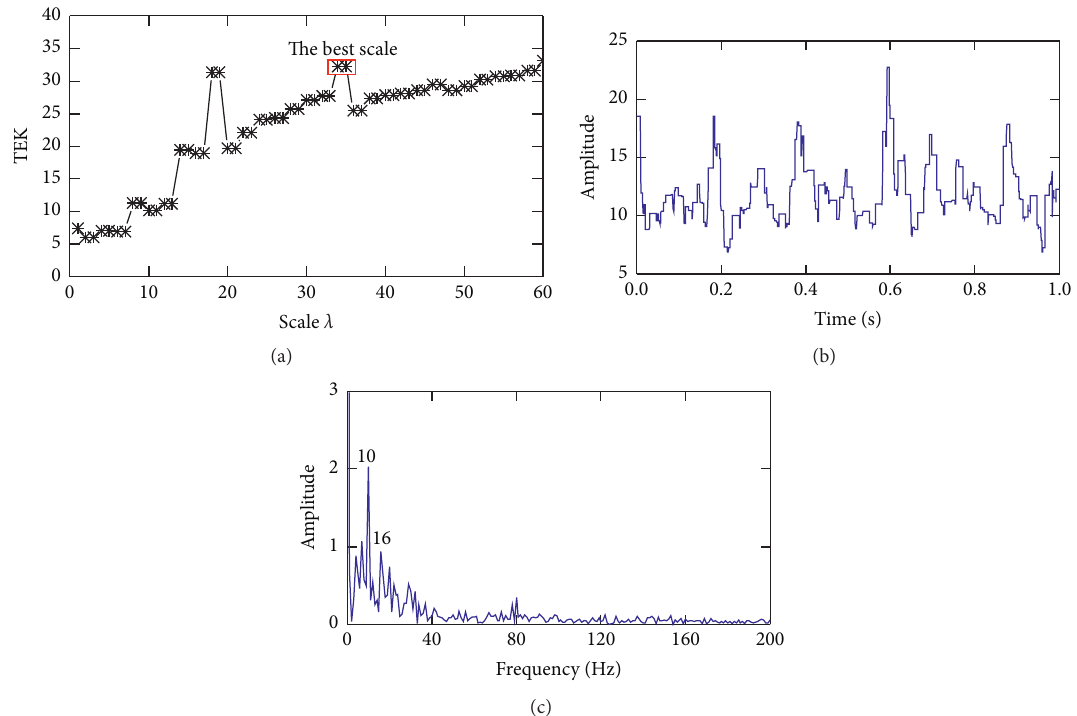
Figure 14: Analysis results of simulation signals by the ACDIF method: (a) correlation curve between TEK and scale λ ; (b) time-domain spectrum; (c) envelope spectrum.